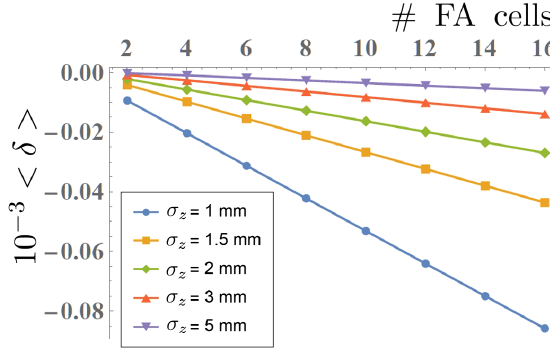
.FIG. 30. The relative energy loss h δ i of a Gaussian beam along 16 FA cells with various initial bunch lengths σ z